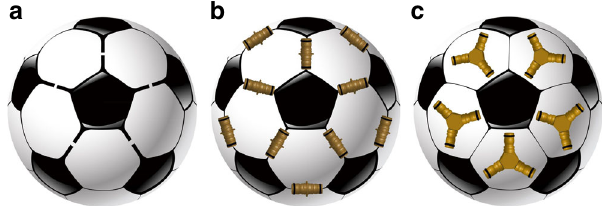
Fig. 1 Three strategies for capsid formation from pentatopic tectons using the common image of a soccer ball: a Self-adhering tectons (black objects). b Tectons (black) with added digonal connectors (golden